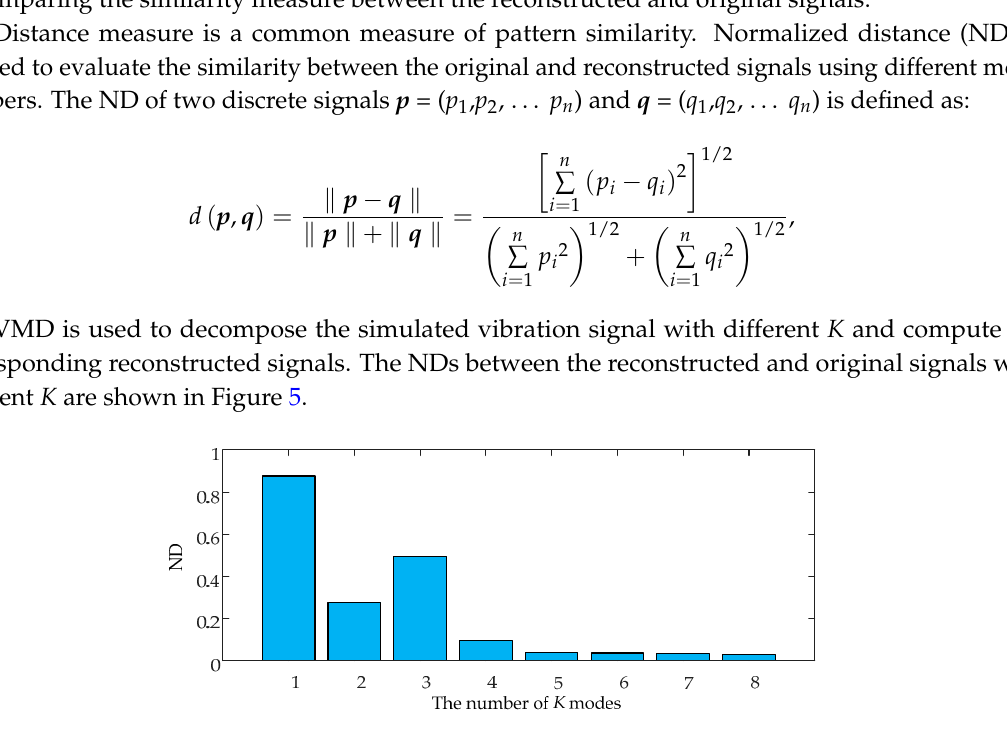
Figure 5. The NDs between the reconstructed signals and the original signals with different K .